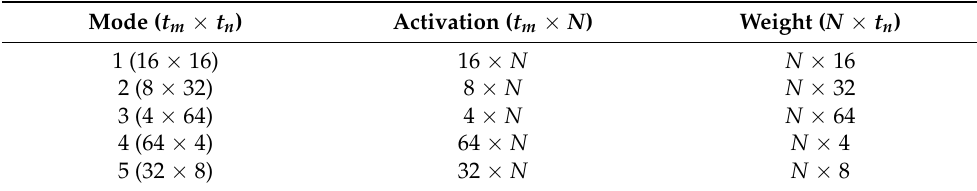
Table 5. Operation modes of CONNA.